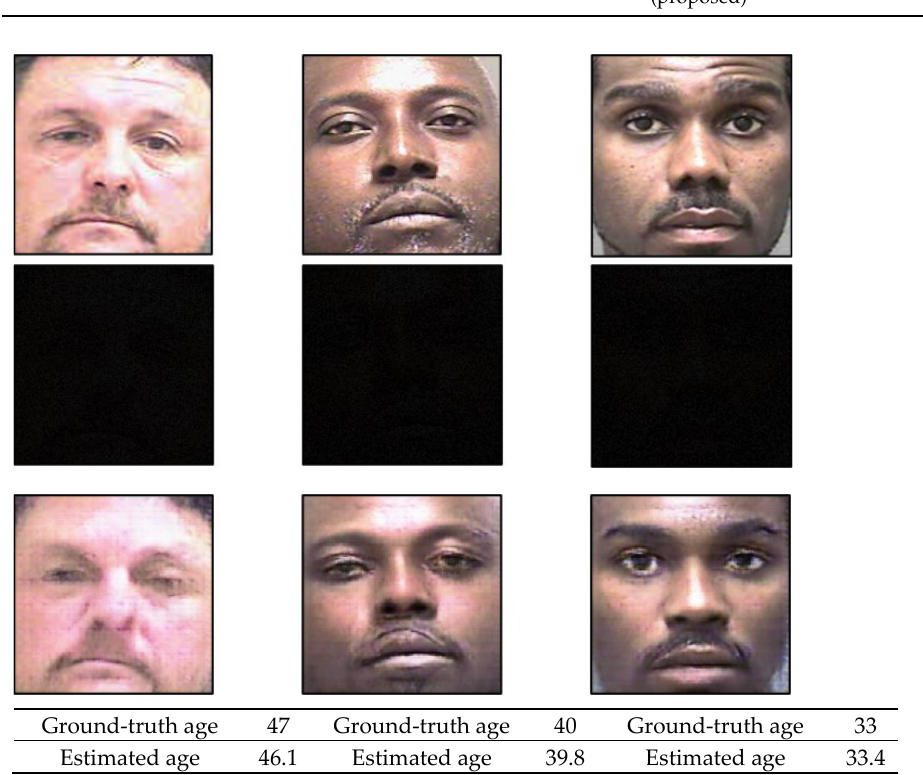
Figure 9. Good cases of age estimation by proposed method. The 1st, 2nd and 3rd rows show the original, low-illuminated images, and the enhanced one by LAE-GAN, respectively.